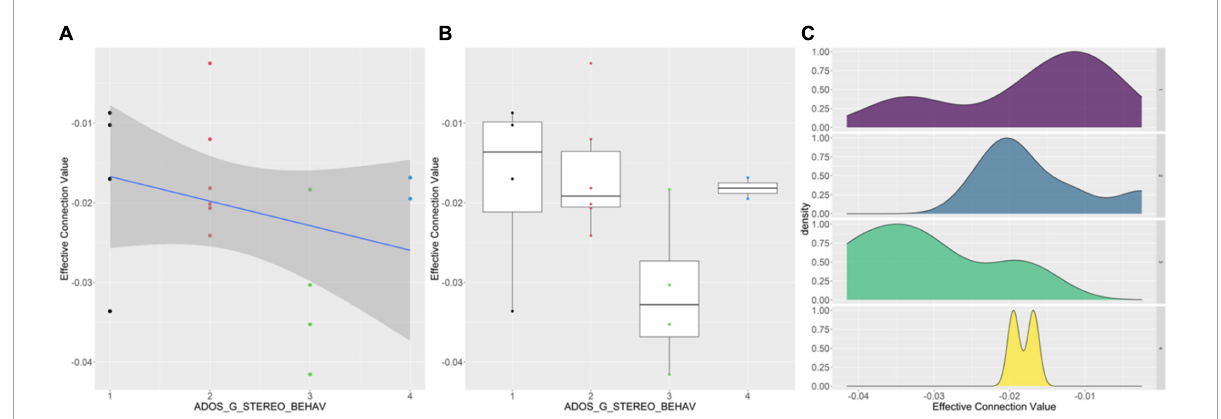
FIGURE5 Correlations between effective connectivity values (from DMN_ANG_R to SMN_PreCG_L) and ADOS_G_STEREO_BEHAV. (A) The effective values and ADOS_G_STEREO_BEHAV has significant negative correlation. (B) The overall trend of ADOS_G_STEREO_BEHAV decreases as the effective connection value decreases. (C) For different ADOS_G_STEREO_BEHAV, the probability density distributions of the effective connection values are significantly